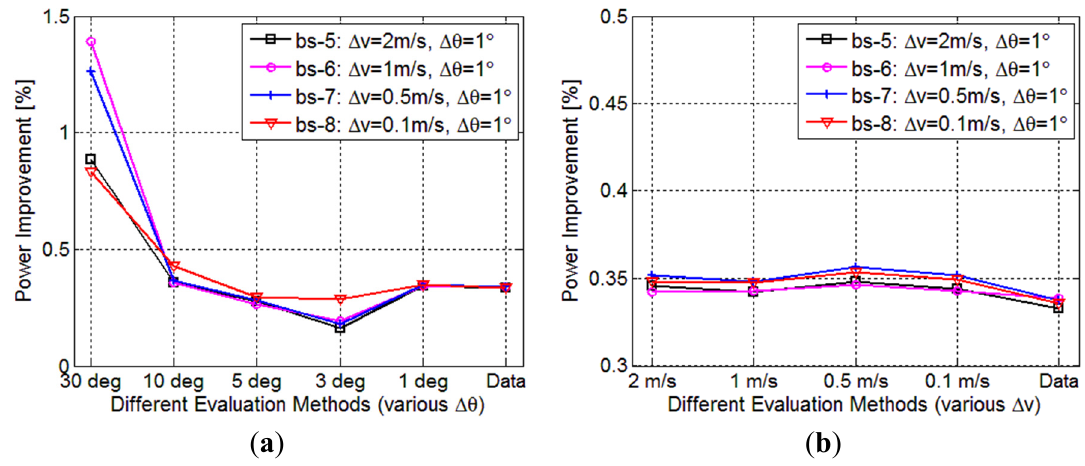
Figure 12. Power improvement of the optimized layouts, obtained with 4 bin size choices bs-5, bs-6, bs-7 and bs-8, re-evaluated with: ( a ) (cid:1986)(cid:1874) (cid:3404) 1 m/s and different (cid:1986)(cid:2016) ; ( b ) (cid:1986)(cid:2016) (cid:3404)